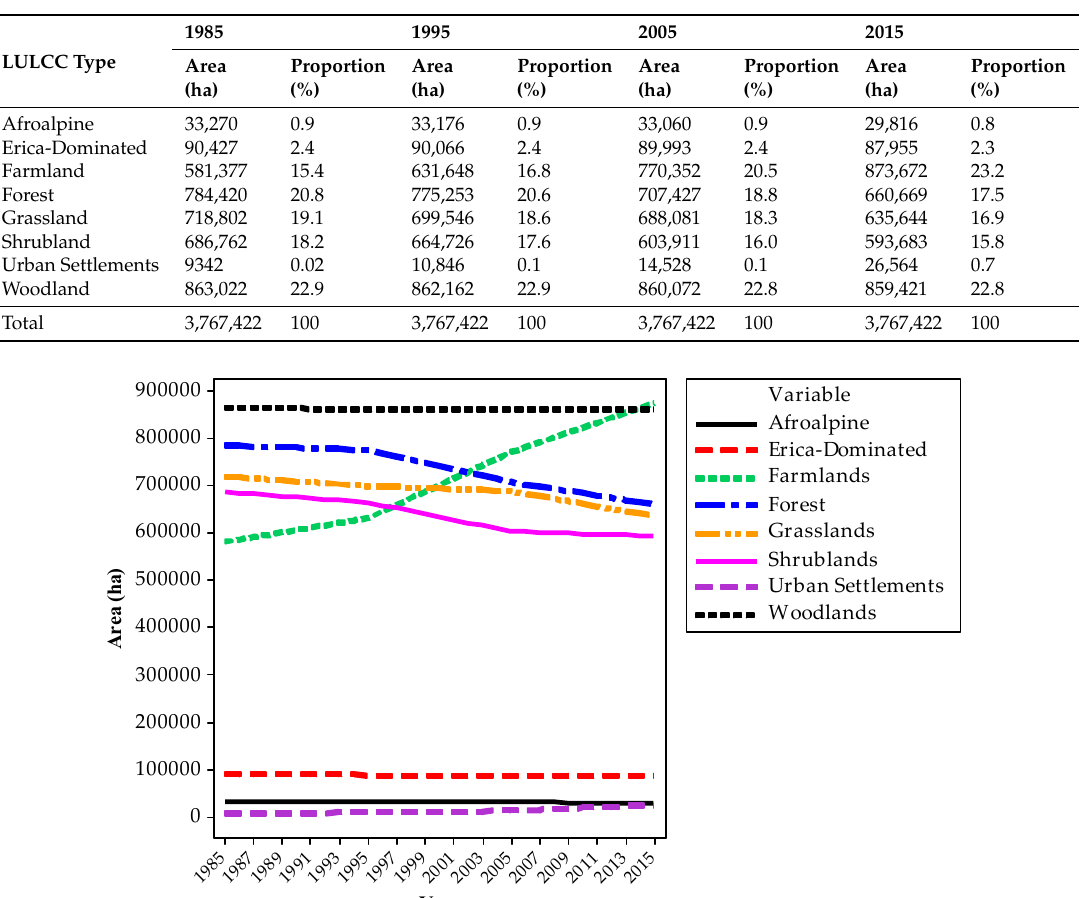
Table 3. Area and proportion of LULC in BMER in 1985, 1995, 2005, and 2015.